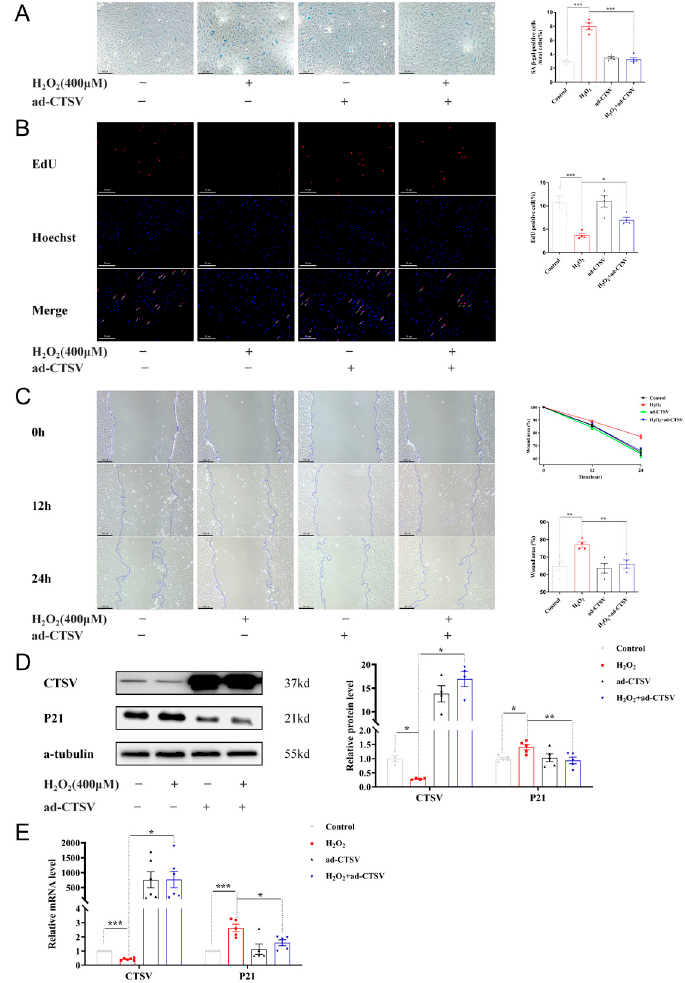
Figure 3. Over-expression of CTSV reduces cellular senescence. ( A ) HUVECs were treated with ad-negative control (NC) or ad-CTSV (MOI = 10) for 8 h and simulated with 400 µ M H 2 O 2 for 24 h after incubated in complete growth medium for 40 h. SA- β -gal activity was analyzed (blue staining for the senescent cells, scale bar = 50 μ m, n = 4). ( B ) EdU assay of the cell proliferation ability in HUVECs treated with H 2 O 2 and ad-CTSV (red staining for the EdU, blue staining for Hoechst, scale bar = 50 μ m, n = 4). ( C ) Representative images of the wound healing assay and the quantification of wound area in HUVECs (scale bar = 100 μ m, n = 4). ( D ) Western blot of CTSV and P21 in HUVECs treated with H 2 O 2 and ad-CTSV ( n = 4–5). ( E ) Relative mRNA level of CTSV and P21 in HUVECs ( n = 5–6). Data are presented as mean ± SEM. One-way ANOVA test was used. * p < 0.05, ** p < 0.01, *** p < 0.001.